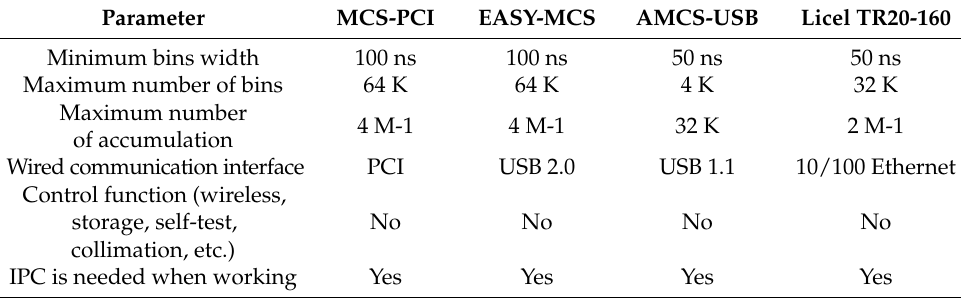
Table 1. Analysis of technical parameters of space-borne lidar.